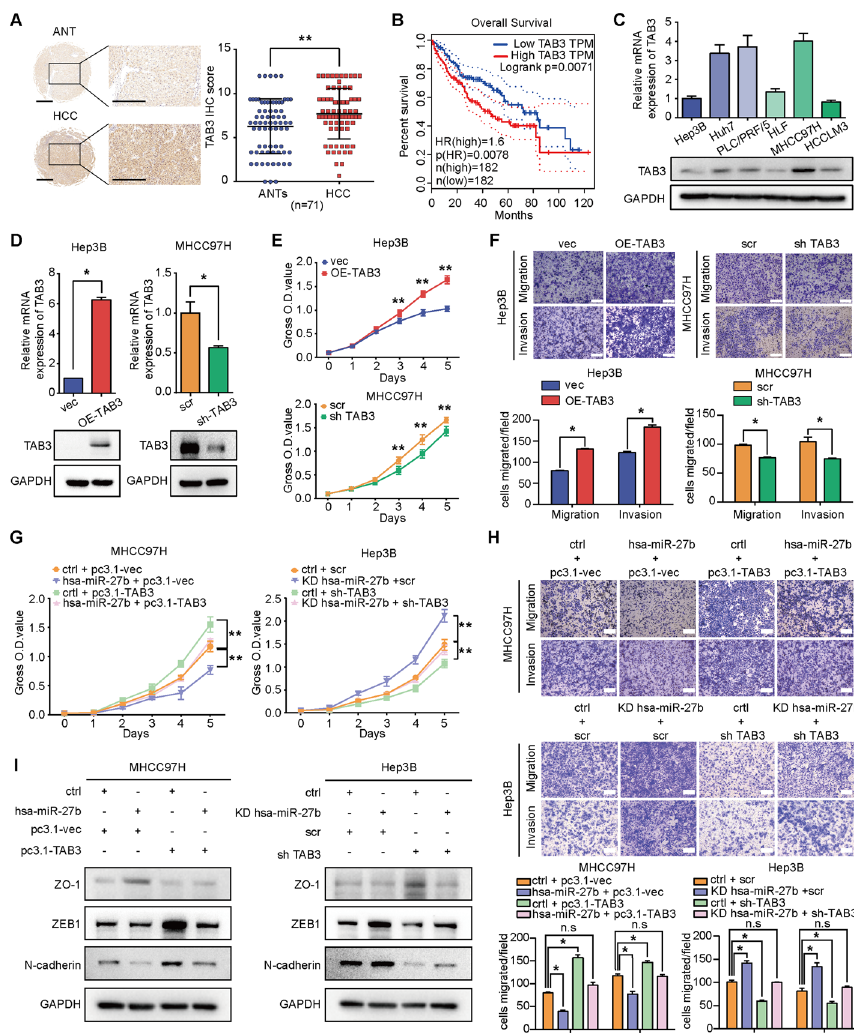
Fig. 5 The impacts of hsa-miR-27b on HCC cells were mediated by TAB3 . A Representative images (left) and quantification (unpaired t -test) (right) of TAB3 IHC staining in 71 pairs of HCC tissues and ANTs. Scale bar: left, 100 μm; right, 200 μm. B Kaplan–Meier analysis of the relationship between TAB3 expression and overall survival of patients with HCC in the GEPIA database (log-rank test). C TAB3 mRNA and protein expression in HCC cell lines as determined by qRT-PCR (top) and western blots (bottom). Data were normalized to GAPDH and are shown as fold change compared with Hep3B cells for qRT-PCR ( n 3). GAPDH was used = as a loading control for western blot analysis. D qRT-PCR (top) and western blot (bottom) analysis of TAB3 overexpression or knockdown efficacy in the indicated cells. Data were normalized to GAPDH and are shown as fold change relative to their respective control cells for qRT-PCR ( n 3, Mann–Whitney test). GAPDH was = used as a loading control for western blot analysis. E CCK-8 assay of the indicated cells ( n 5, Kruskal–Wallis = test). F Representative images of cell migration and invasion in the indicated groups (top). Scale bar, 200 μm. Quantification of cell migration and invasion ( n 3, Mann–Whitney test) (bottom). G CCK-8 assay for the = indicated cell groups ( n 5, Kruskal–Wallis test). H Representative images and quantification of migrated and = invaded cells in the indicated cell groups ( n 3, Mann–Whitney test). Scale bar, 200 μm. I Western blotting = for EMT markers as indicated. GAPDH was used as a loading control. C – I were repeated three times. * p < 0.05. ** p < 0.01. Data are shown as mean SD. ANTs, adjacent non-tumourous tissues; HCC, hepatocellular ± carcinoma; vec, vector; OE, overexpression; scr, scramble; sh, small hairpin RNA; ctrl, control; vec, vector; pc3.1-, pcDNA3.1-; KD, knockdown; sh, small hairpin